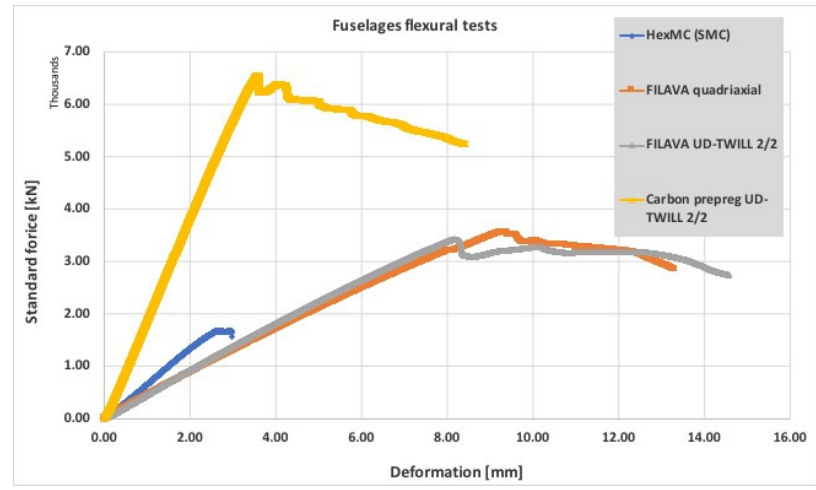
Figure 13. Flexural results of the fuselages.